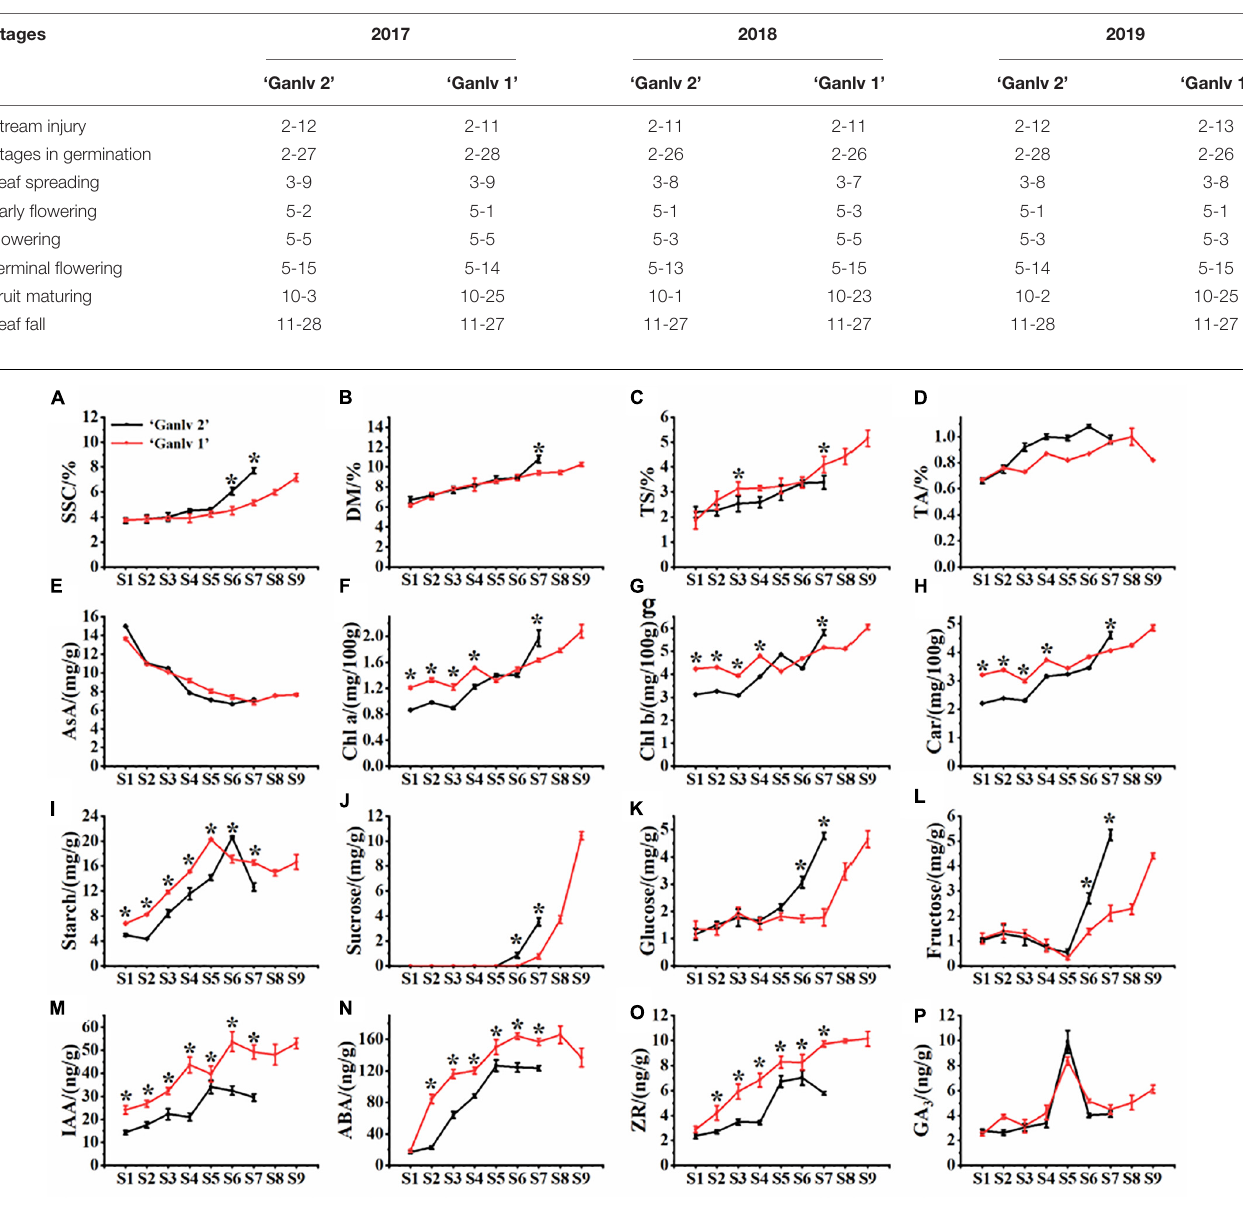
FIGURE 2 | Dynamic change characteristics of inner quality [ (A) soluble solids content, (B) dry matter, (C) soluble sugar content, (D) titratable acid content, (E) ascorbic acid content, (F) chlorophyll a , (G) chlorophyll b , (H) carotenoids, (I) starch, (J) sucrose, (K) glucose, and (L) fructose] and endogenous hormone content [ (M) indole-3-acetic acid, (N) abscisic acid, (O) zeatin, and (P) gibberellin] of ‘Ganlv 2’ and ‘Ganlv 1’. *represents that there are significant differences between different cultivars at same period on same index, p 0.05. The red line represents ‘Ganlv 1’ and the black line represents ‘Ganlv